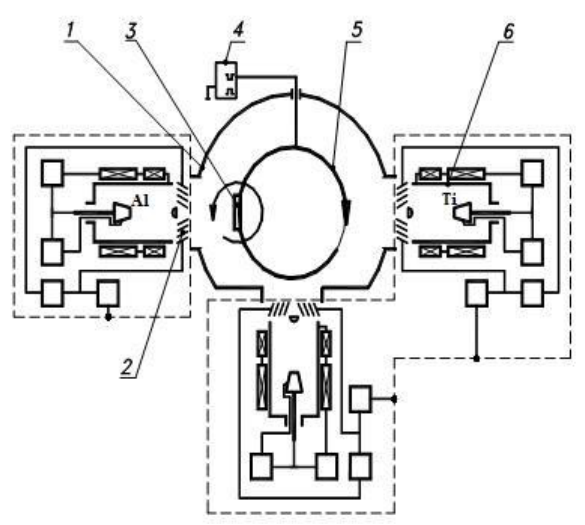
Figure 1. Schematic diagram of the experimental technique: 1—vacuum chamber; 2—plasma filter; 3—sample; 4—bias voltage supply; 5—rotary device; 6—arc evaporator.